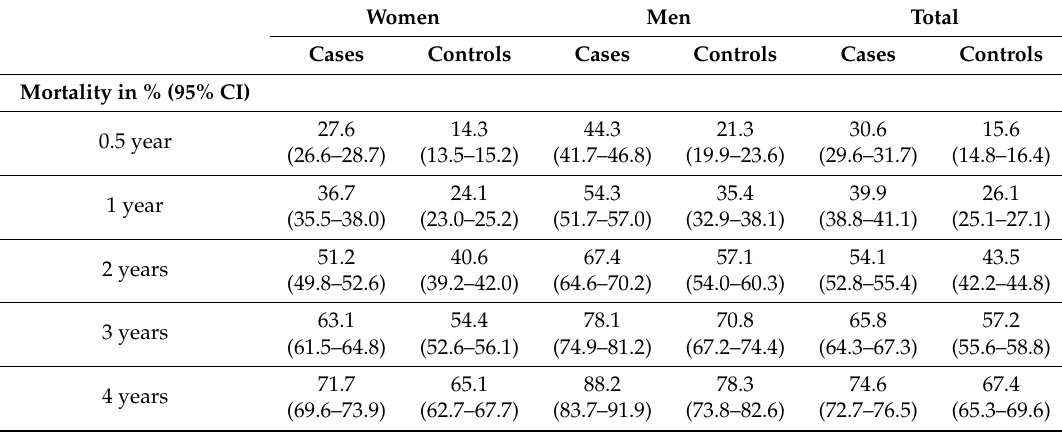
Figure 2. Kaplan–Meier-Plot: Survival probability of the hip fracture group ( n = 8535) and in controls ( n = 8535) with 95% Hall–Wellner Bands and number of individuals at risk. Table 2. Mortality in the hip fracture group ( n = 8535) and in controls * ( n = 8535) with 95% CI in different periods after index-date.